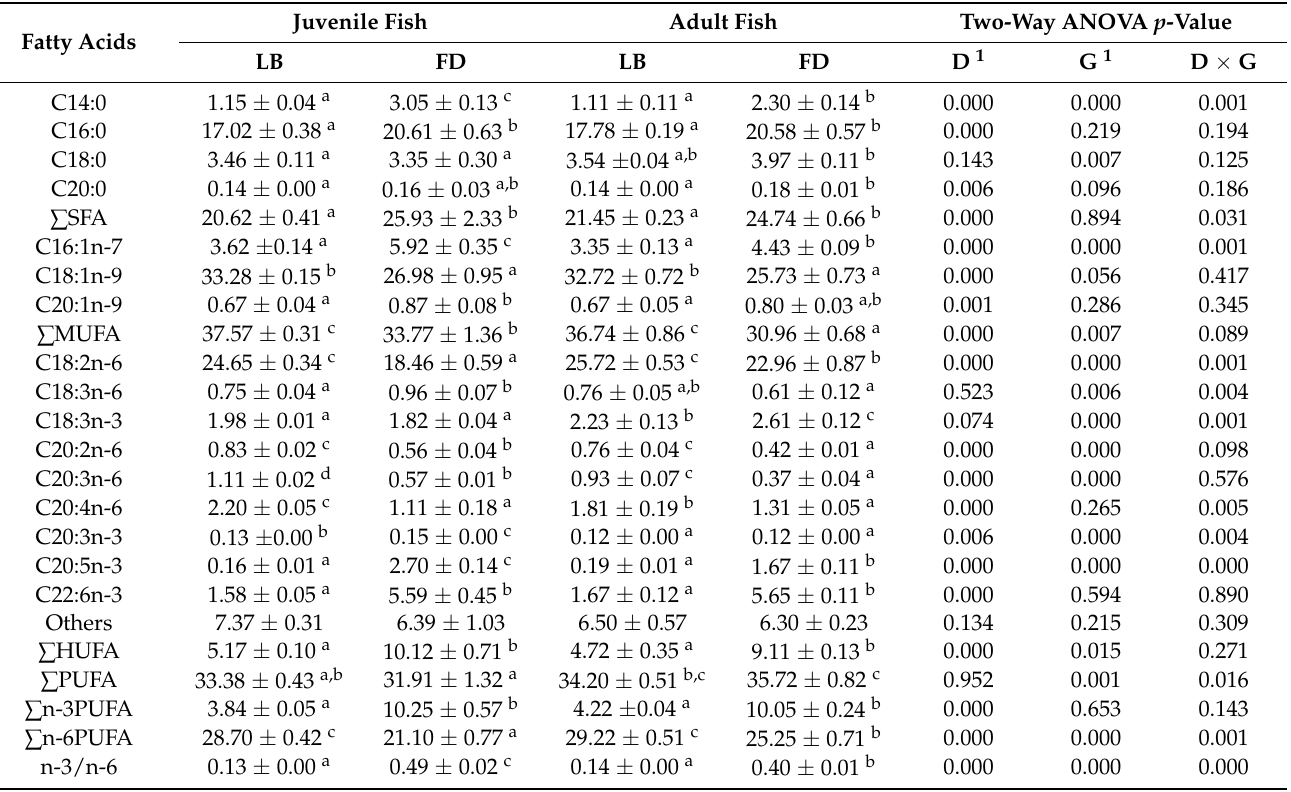
Table 7. Effects of live baits and formulated diet on the muscle fatty acid composition in muscle of Siniperca chuatsi at different growth stages (% total fatty acids) 1